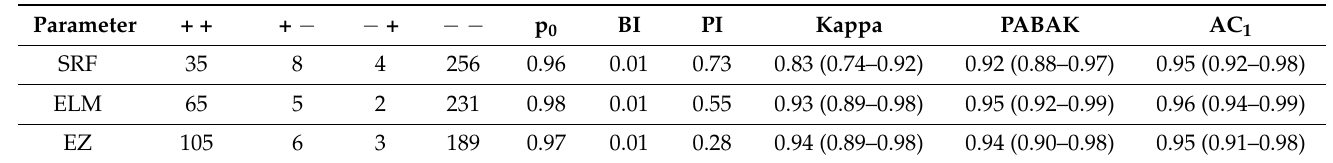
Table 3. Inter-rater agreement κ between artificial intelligence (AI) software and clinical evaluation.